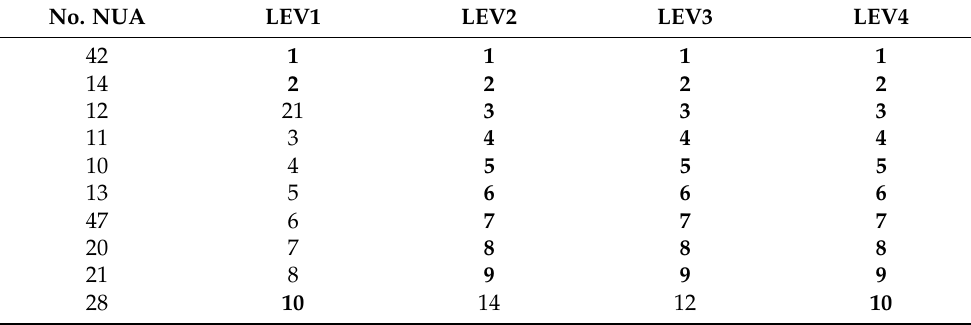
Table 6. NUA ranking in terms of the dMtot. The bold value represents the NUAs rank that shows the correspondence between the scenarios (LEV1, LEV2, LEV3) and the LEV4.